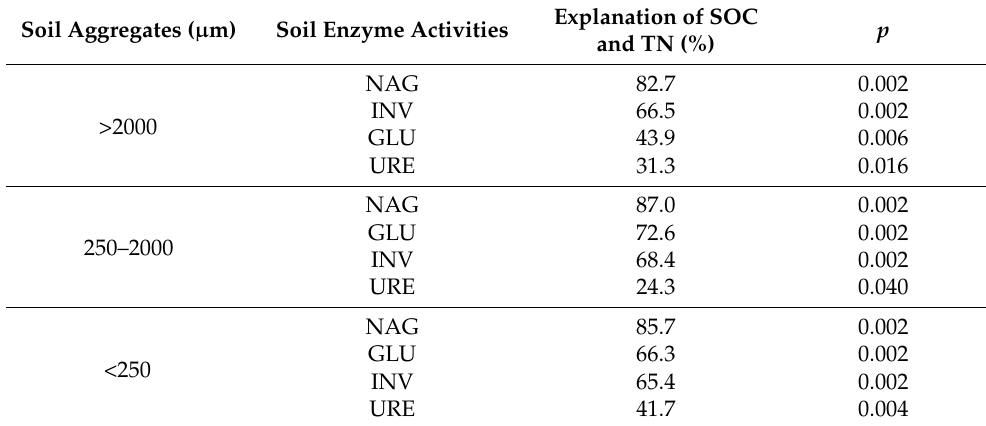
Table 3. Importance and significance levels of soil enzyme activities in soil aggregates. Soil Aggregates ( µ m) Soil Enzyme